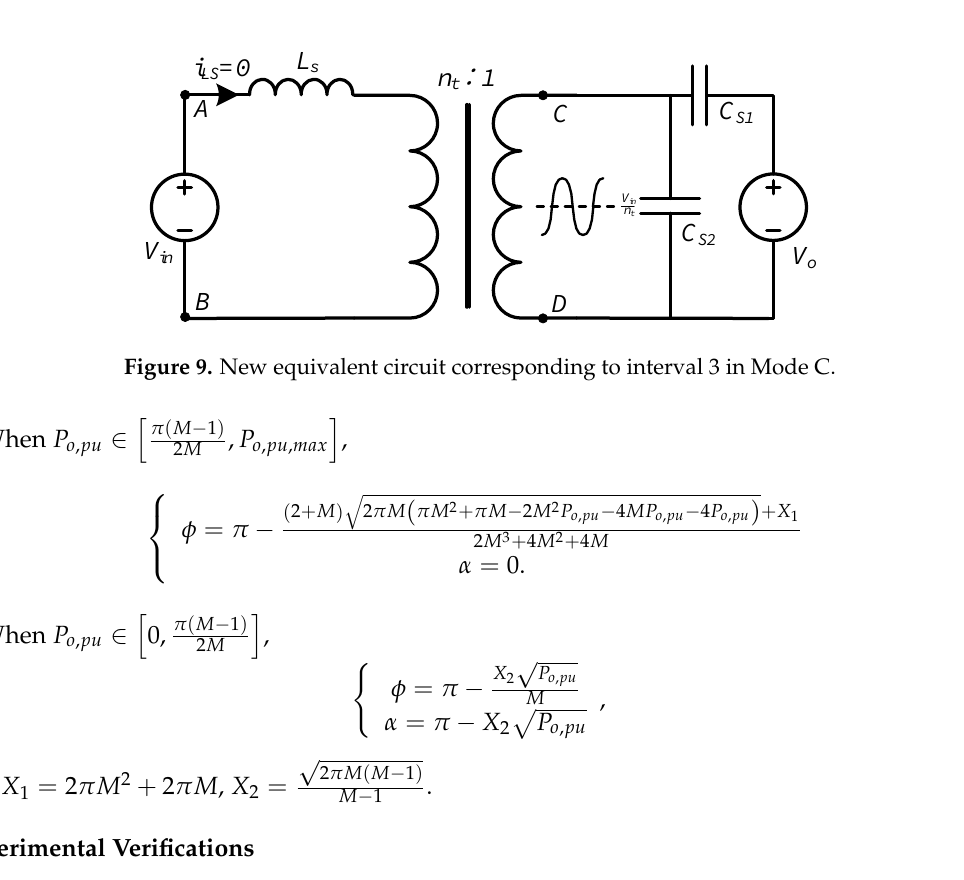
Figure 8. Normalized inductor RMS current vs. phase-shift α at different power contours for M = 1.5.